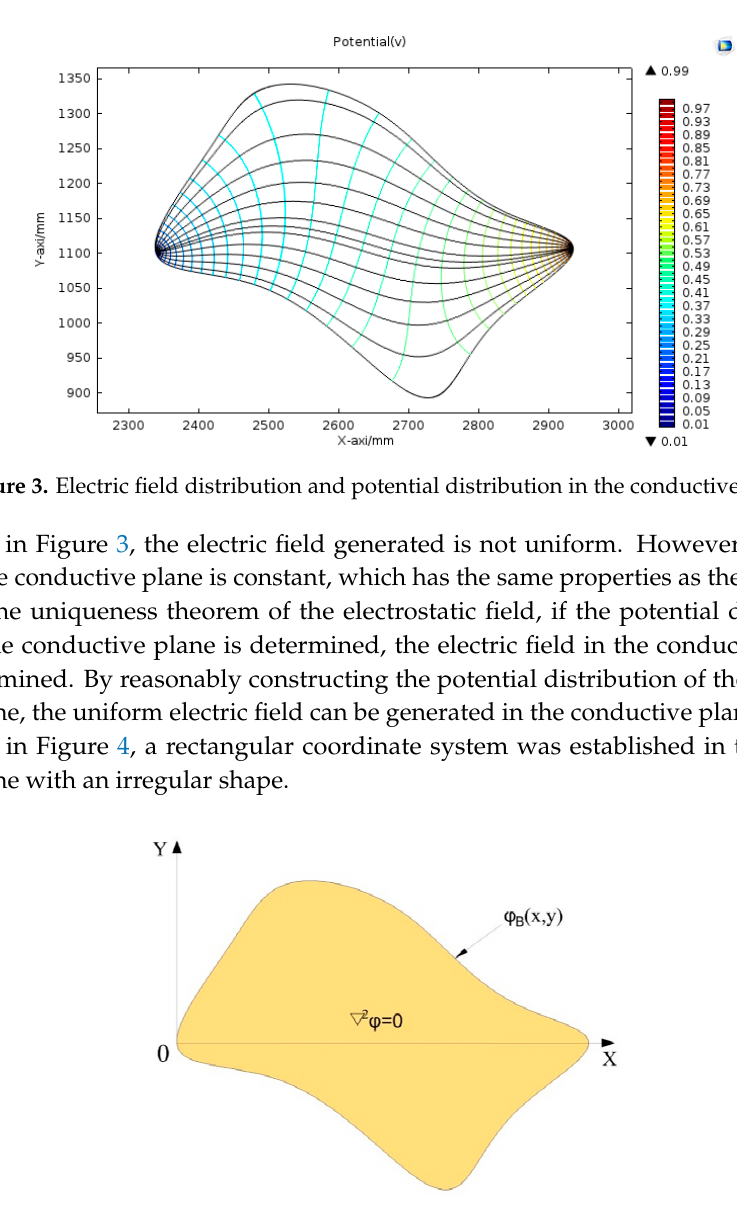
Figure 4. Irregular shaped homogeneous conducting plane in the rectangular coordinate system.